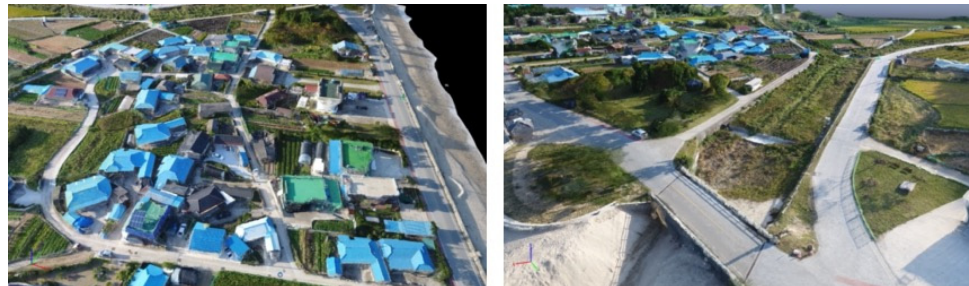
Figure 11. Georeferenced 3D point cloud model showing different views with ground control points (GCPs).